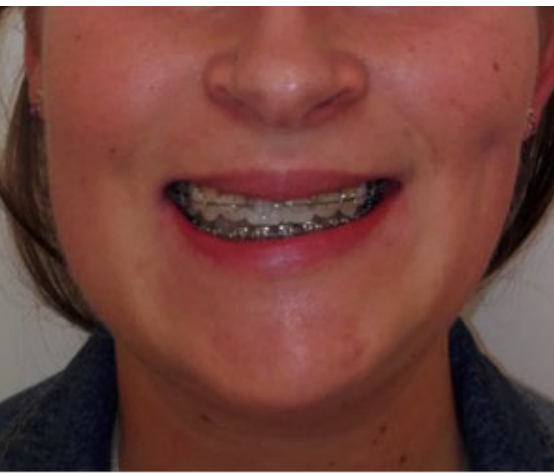
Figure 13. Some results could be still unsatisfactory because of the lack of chin and lower border of the mandible harmony. In those cases, during plate removal after orthognathic surgery, it is relatively easy to combine a definitive mandibular correction procedure with titanium miniplate removal.